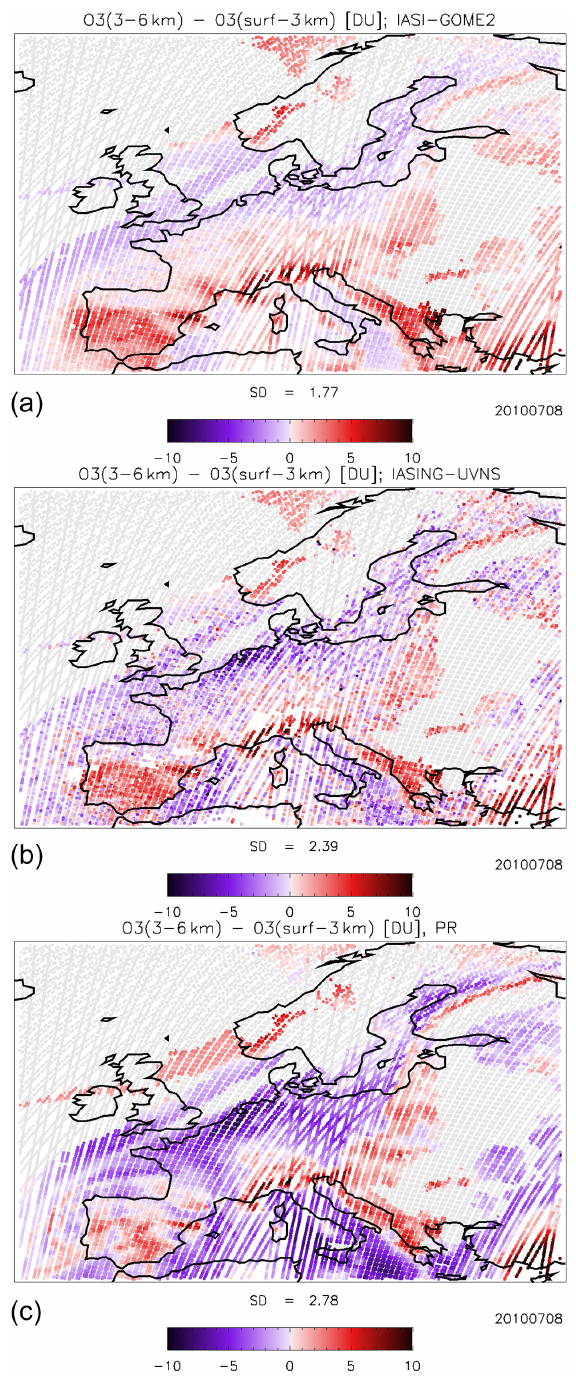
Figure 11. Maps of pixel-by-pixel difference between ozone partial columns [DU] calculated in the surface–3km and 3–6km altitude bands, for 8 July 2010. Negative values (purple) indicate stronger ozone concentration in the LMT than above. Regional standard de- viation (SD) value is reported in the